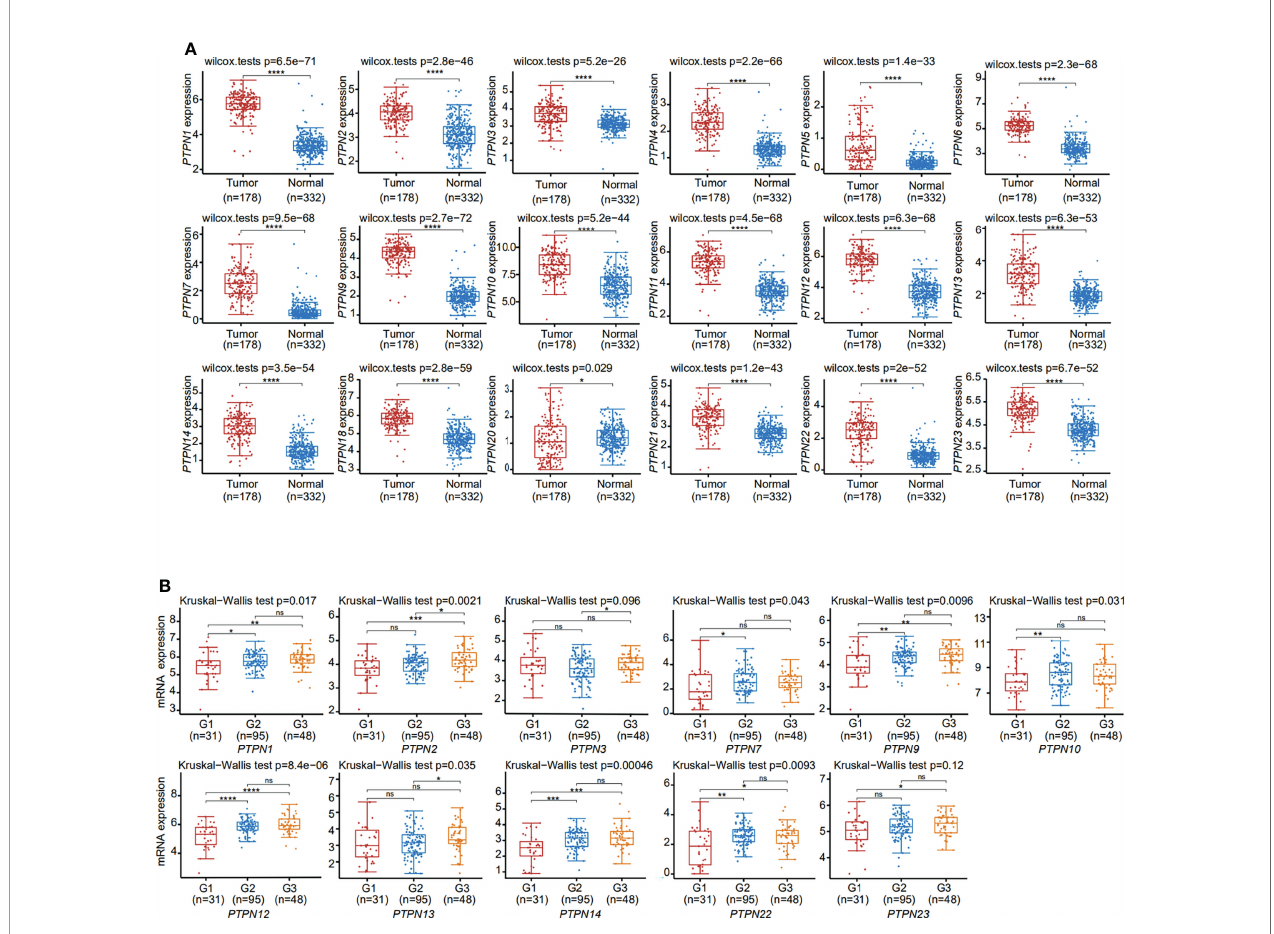
FIGURE 2 | Expression of PTPNs in pancreatic adenocarcinoma. (A) The differentiation and expression of PTPN in tumor and adjacent tissues. (B) The signi fi cant differential expression of PTPNs at different grades. ns, No Signi fi cant. *p < 0.05, **p < 0.01, ***p < 0.001, ****p <